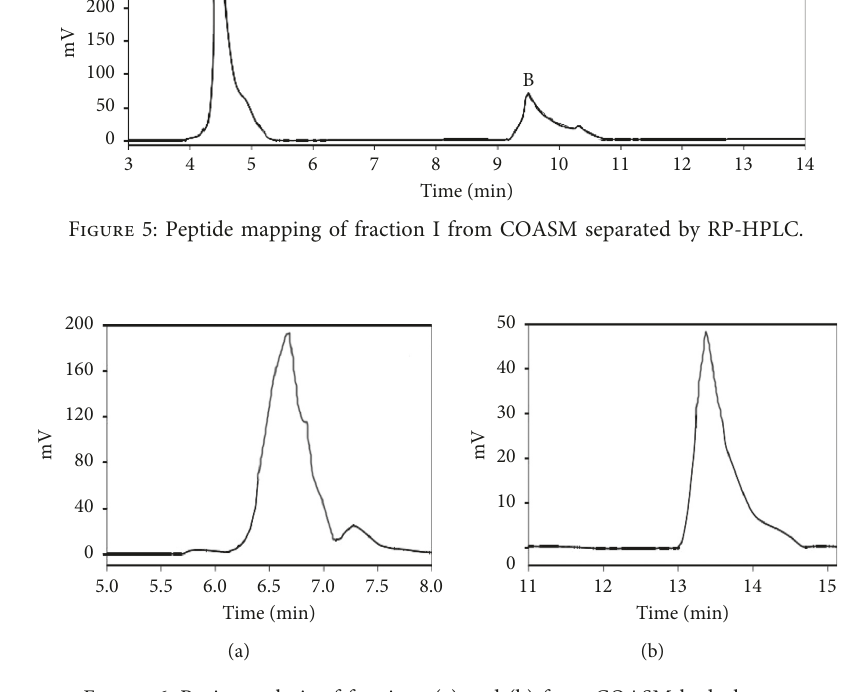
Figure 6: Purity analysis of fractions (a) and (b) from COASM